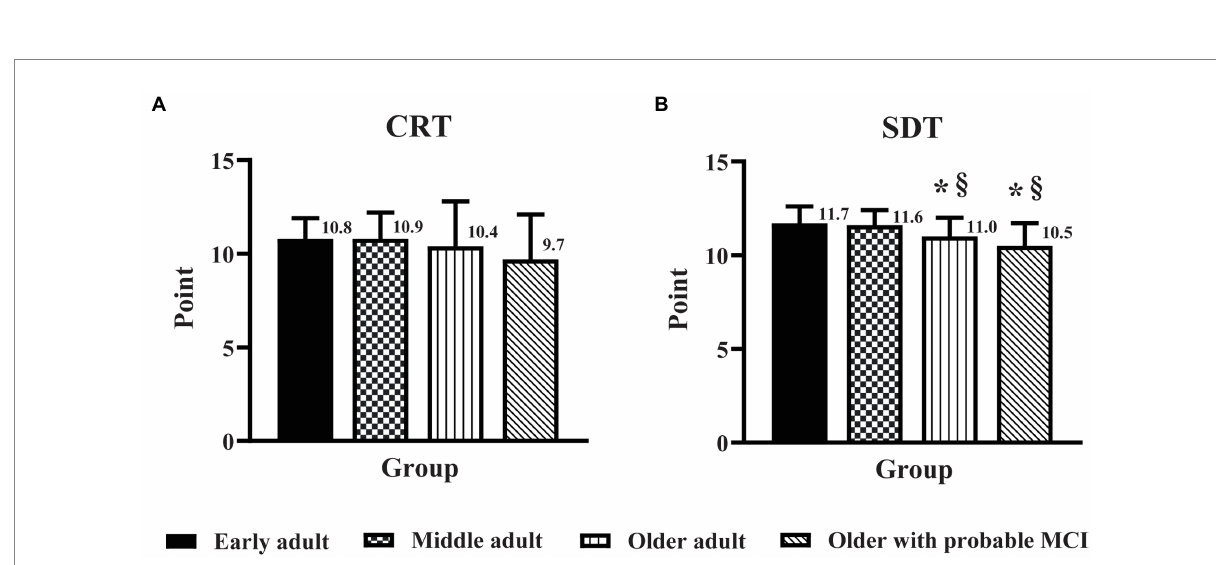
FIGURE 3 The influence of education level on the effect of age and mild cognitive impairment on the domains of perceptual-motor function. Perceptual- motor function was assessed by the clock reading test (A) and the stick design test (B) in early adult, middle adult, older adult, and older adults with probable MCI and a high education level. CRT, clock reading test; SDT, stick design test; MCI, mild cognitive impairment. * p < 0.05 vs. early adult group; § p < 0.05 vs. middle adult